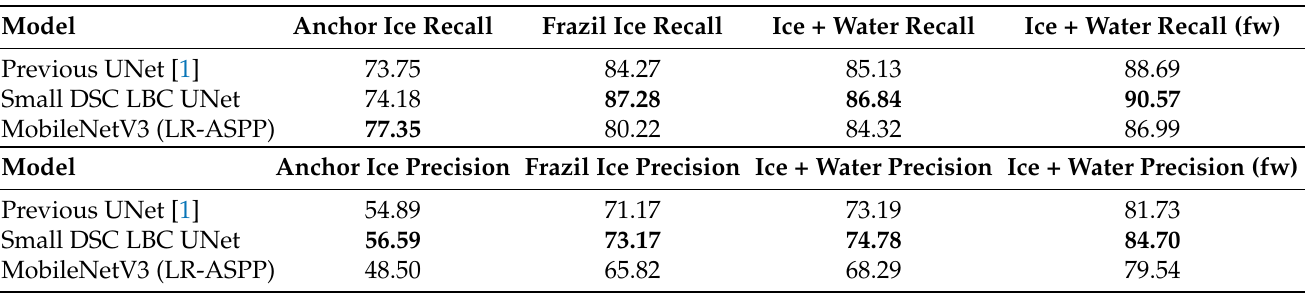
Table A1. Metric comparison of the Small DSC LBC UNet and MobileNetV3 (LR-ASPP) with the UNet tested in previous work using the same training and testing split. Recall and precision for the two ice types correspond to class specific pA and fwIoU . Ice + Water recall and precision correspond to mPA and mIoU respectively for all classes. The frequency weighted (fw) equivalents for Ice + Water recall and precision correspond to pA and fwIoU respectively for all